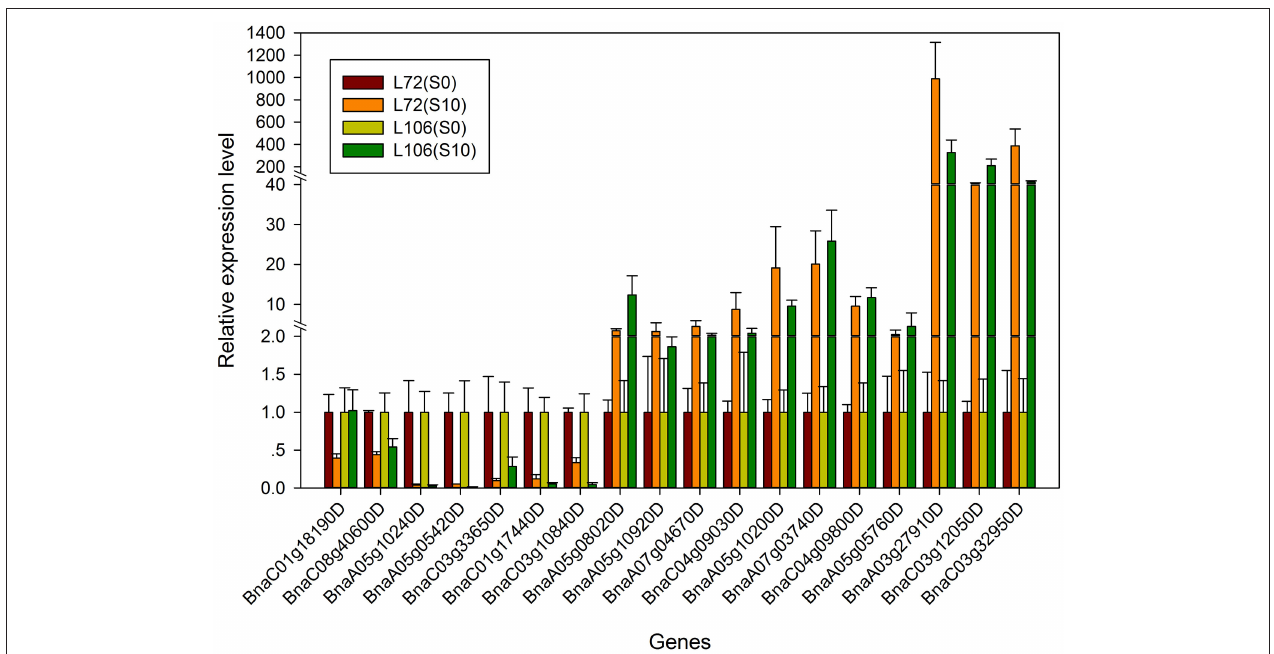
FIGURE 7 | The relative expression level of the 18 genes from real-time quantitative PCR (qRT-PCR) in two B. napus accessions (L72: MUTU and L106: Alku). S10, seedlings sampled after exposure to − 1.0MPa water stress for 6h; S0, seedlings sampled in the parallel control condition.